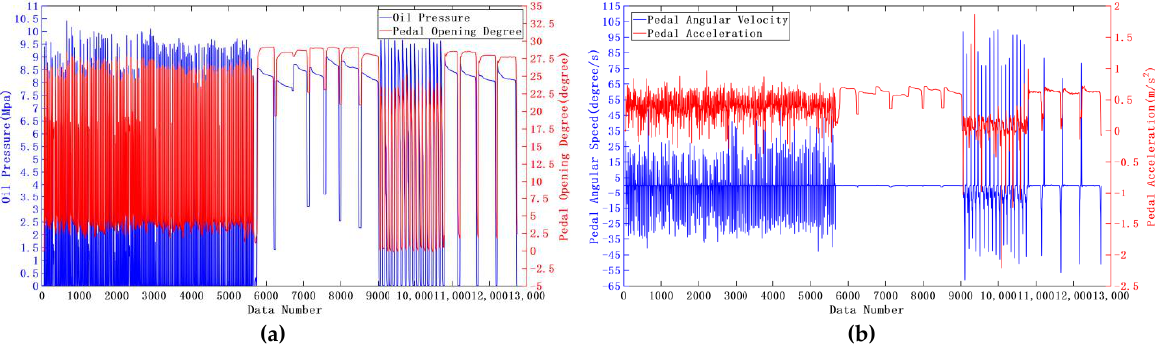
Figure 6. Sampled data under emergency braking conditions: ( a ) Sampled data of actual oil pressure and θ . ( b ) Sampled data of ω and α .